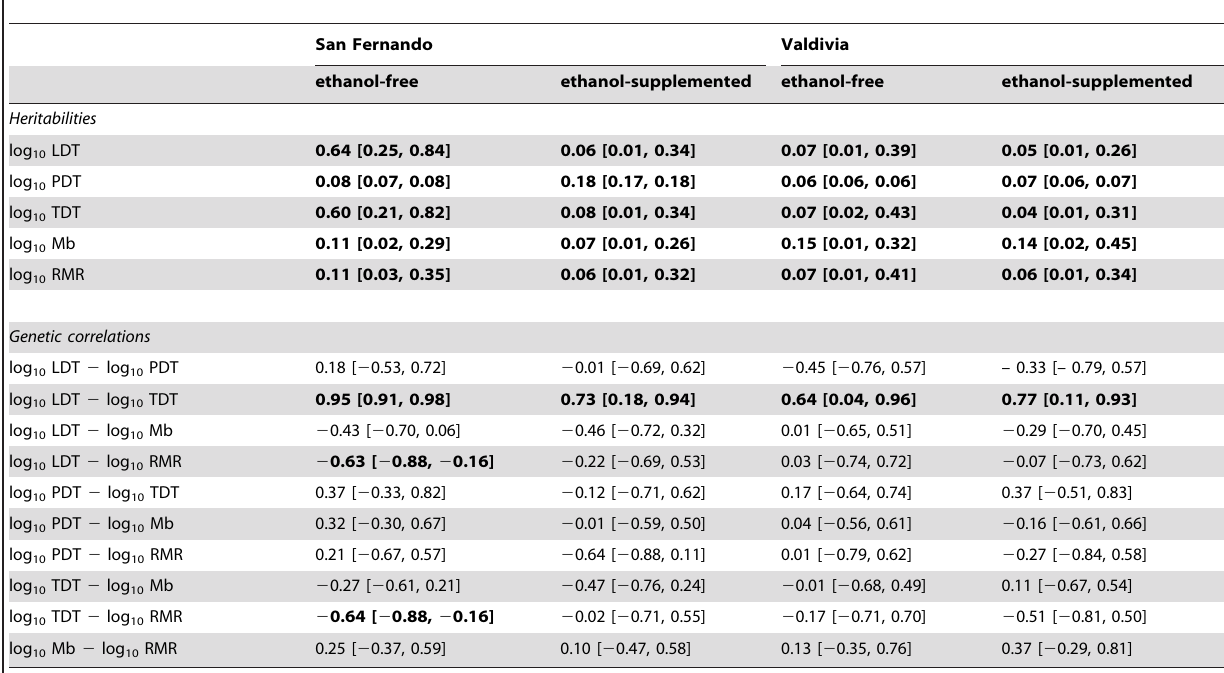
Table 1. Heritabilities and genetic correlations of developmental and physiological traits for Drosophila melanogaster flies developed in contrasting ethanol